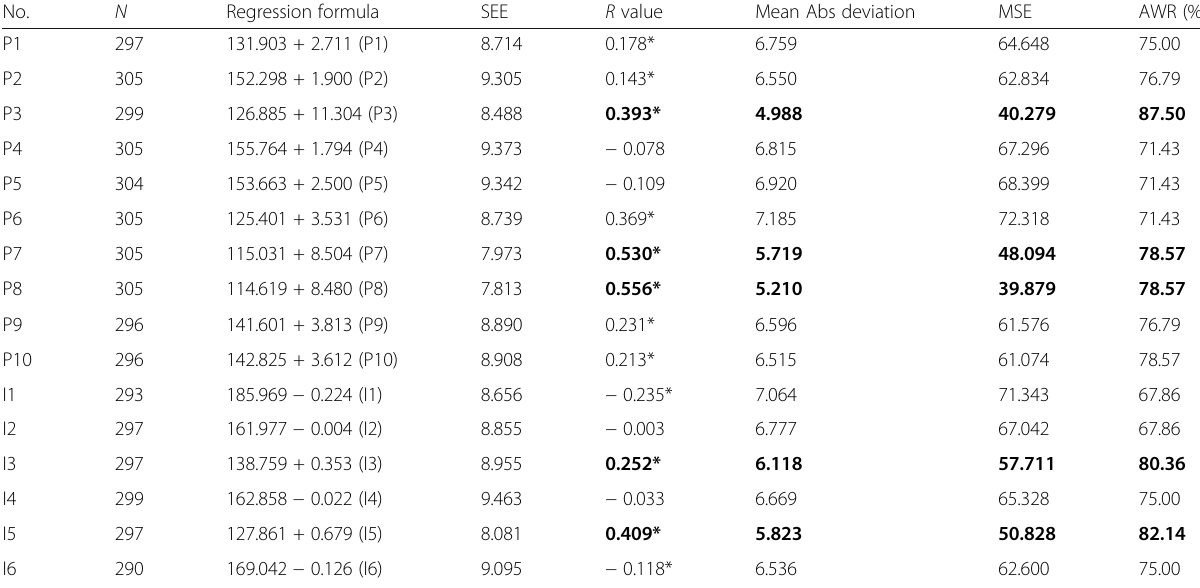
Table 7 Correlation and regression statistics for individual parameters and indices of sacral morphometric against stature in validation analysis